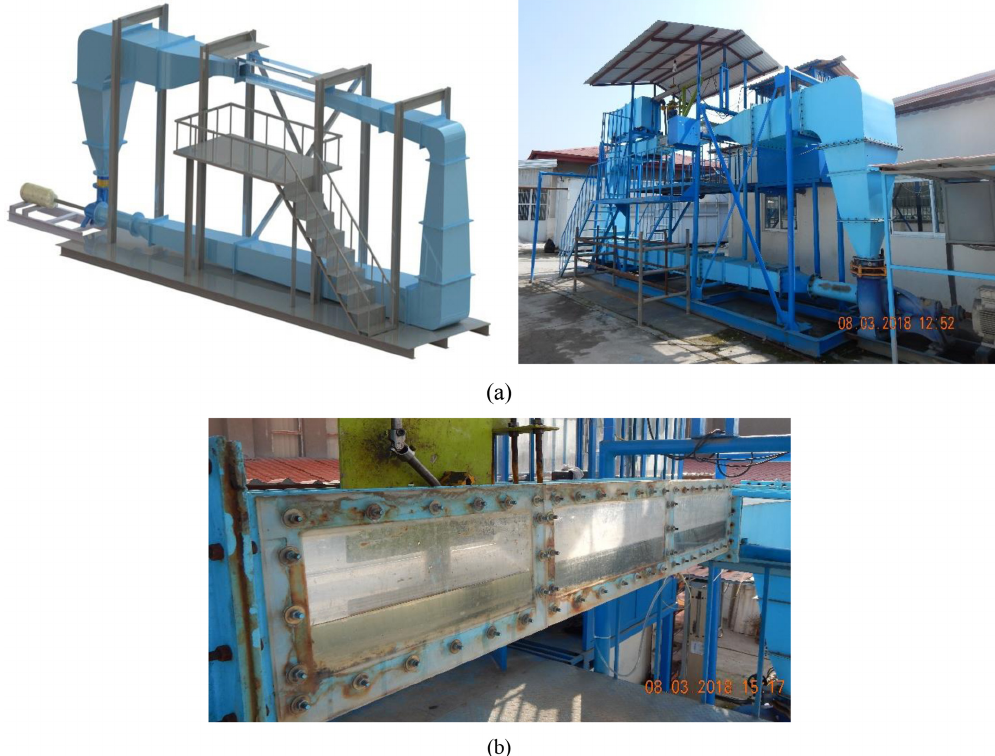
Figure 2. (a) Free surface water tunnel of the Sea-based Energy Research Group at Babol Noshirvani University of Technology and (b) the test